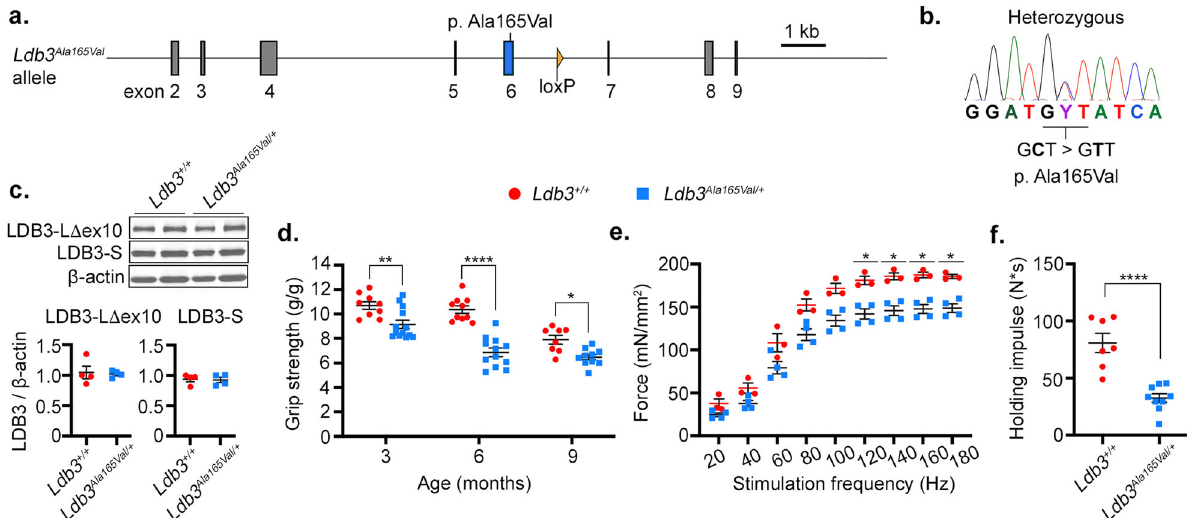
Fig. 1 Generation and phenotyping of Ldb3 Ala165Val/ + mice. a Knock-in of the p.Ala165Val mutation in exon 6 (blue) of the mouse Ldb3 gene. Residual loxP site post- Cre recombination is seen in intron 6 (orange triangle). b Sanger sequence shows the heterozygous C> T mutation changing the codon GCT (Ala) to GTT (Val). c Immunoblotting analysis (blot and dot plot) of the LDB3 isoforms expression relative to β − actin in the vastus muscle of 8-month-old Ldb3 Ala165Val/ + mice (blue) and Ldb3 + / + littermates (red). n = 4 each, represents triplicate assay. d Dot plot comparing maximum all paws grip force of fi ve pulls per mouse normalized to body weight (g/g) between Ldb3 Ala165Val/ + mice (blue) and Ldb3 + / + littermates (red) at 3, 6, and 9 months of age. Mean ± SEM: 9.2± 0.3 g/g versus 10.7 ±0.3g/g at 3 months, 6.9±0.3g/g versus 10.4± 0.3 g/g at 6 months, and 6.5±0.2g/g versus 7.9± 0.3 g/g at 9 months; n = 10 – 13 Ldb3 Ala165Val/ + mice and n = 8 – 10 Ldb3 + / + mice per age group. The two-way ANOVA Bonferroni ’ s multiple comparisons test signi fi cant p values between groups are shown. e Dot plot shows maximal isometric force (mN/mm 2 ) generated by the extensor digitorum longus muscle of 6-month-old male Ldb3 Ala165Val/ + mice (blue) versus Ldb3 + / + littermates (red) against stimulation frequencies (Hz). Mean ±SEM: 148±5 mN/mm 2 versus 187±3 mN/mm 2 ; 160Hz; n = 4 Ldb3 Ala165Val/ + mice and n = 3 Ldb3 + / + mice. The two-way ANOVA Bonferroni ’ s multiple comparisons test signi fi cant p values between groups are shown. f Dot plot shows the maximum holding impulse (N*s) in the four-limb wire grid holding test in 9-month-old male Ldb3 Ala165Val/ + mice and Ldb3 + / + littermates. Mean ±SEM: 32±4 N*s versus 81± 8 N*s; n = 9 Ldb3 Ala165Val/ + mice and n = 7 Ldb3 + / + mice. Male mice were used in these tests as female mice showed intra- and inter-group variability. The two-tailed unpaired t -test comparison signi fi cance between groups is shown. * p <0.05, ** p < 0.01, **** p < 0.0001. The error bars in dot plots represent Mean